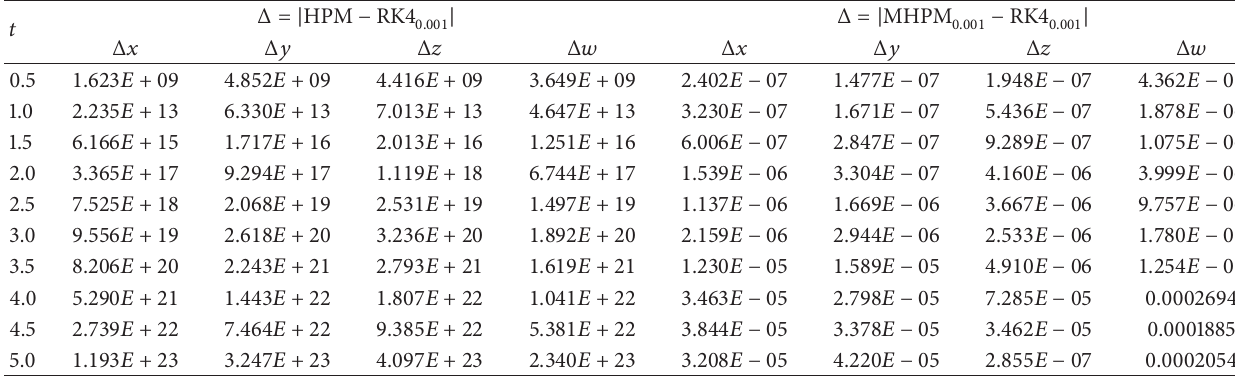
Table 7: Differences between 15-term HPM and 15-term MHPM with RK4 solutions on Δ𝑡 = 0.001 .